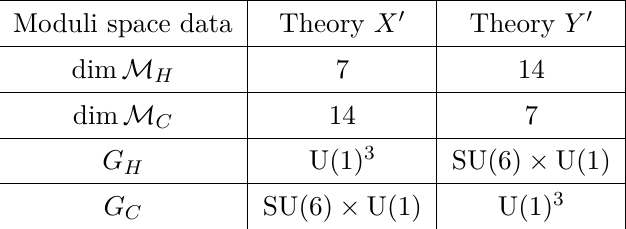
Table 2 . Summary table for the moduli space dimensions and global symmetries for the mirror pair in figure